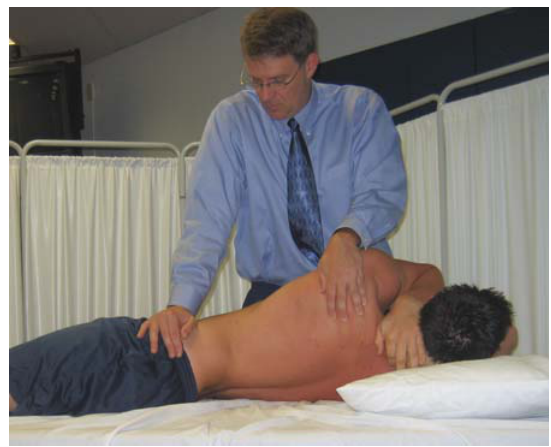
FIGURE 1. Technique of manipulation of lumbosacral region used in studies by Childs et al.[53] and Flynn et al.[54].